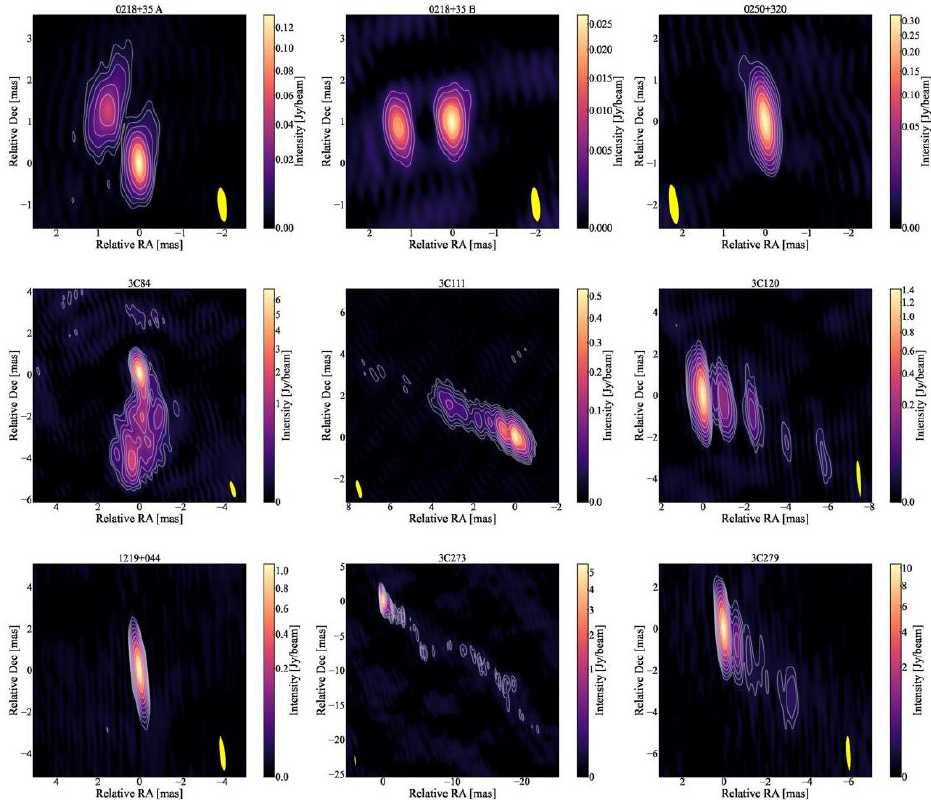
Figure 6. This figure shows a summary of the natural weighted images obtained from EATING VLBI. For each image, contours start from 1, 2, 4 ...times a 3 σ image rms level and increase by factors of 2, and the color bar shows the intensity. The yellow ellipse in the bottom is the beam size of the each map. Image parameters are reported in Table